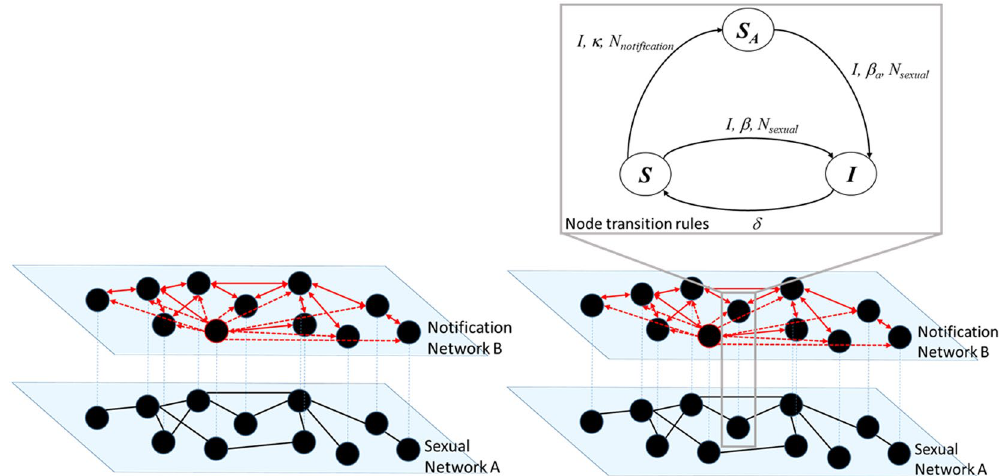
Figure 4. Left: The multi-layer architecture of interactions between individuals. Right: transition diagram for each node in the network among the three states: susceptible (s), alert (s a ), and infected (i), when the transition to the alert state can be induced by infected neighbors in the notification